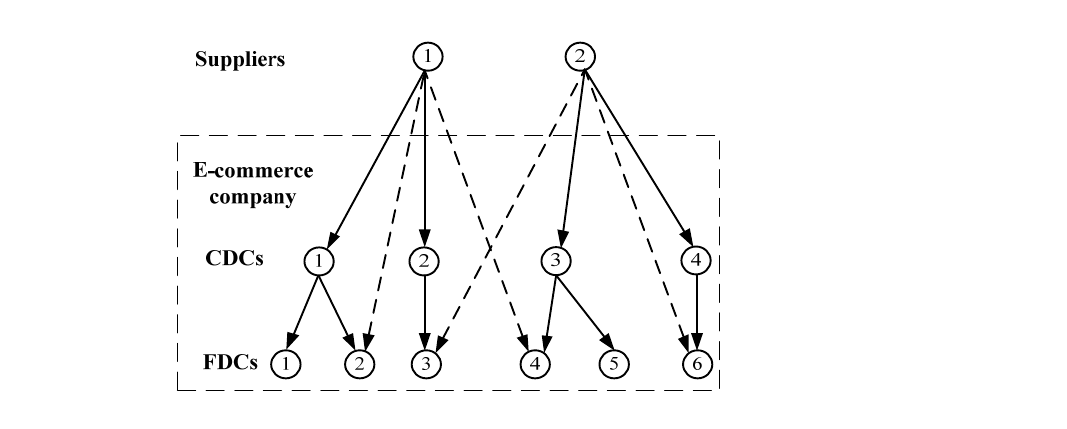
Figure 2. A three-echelon distribution system of Alibaba. CDC, central distribution center; FDC, front distribution center.